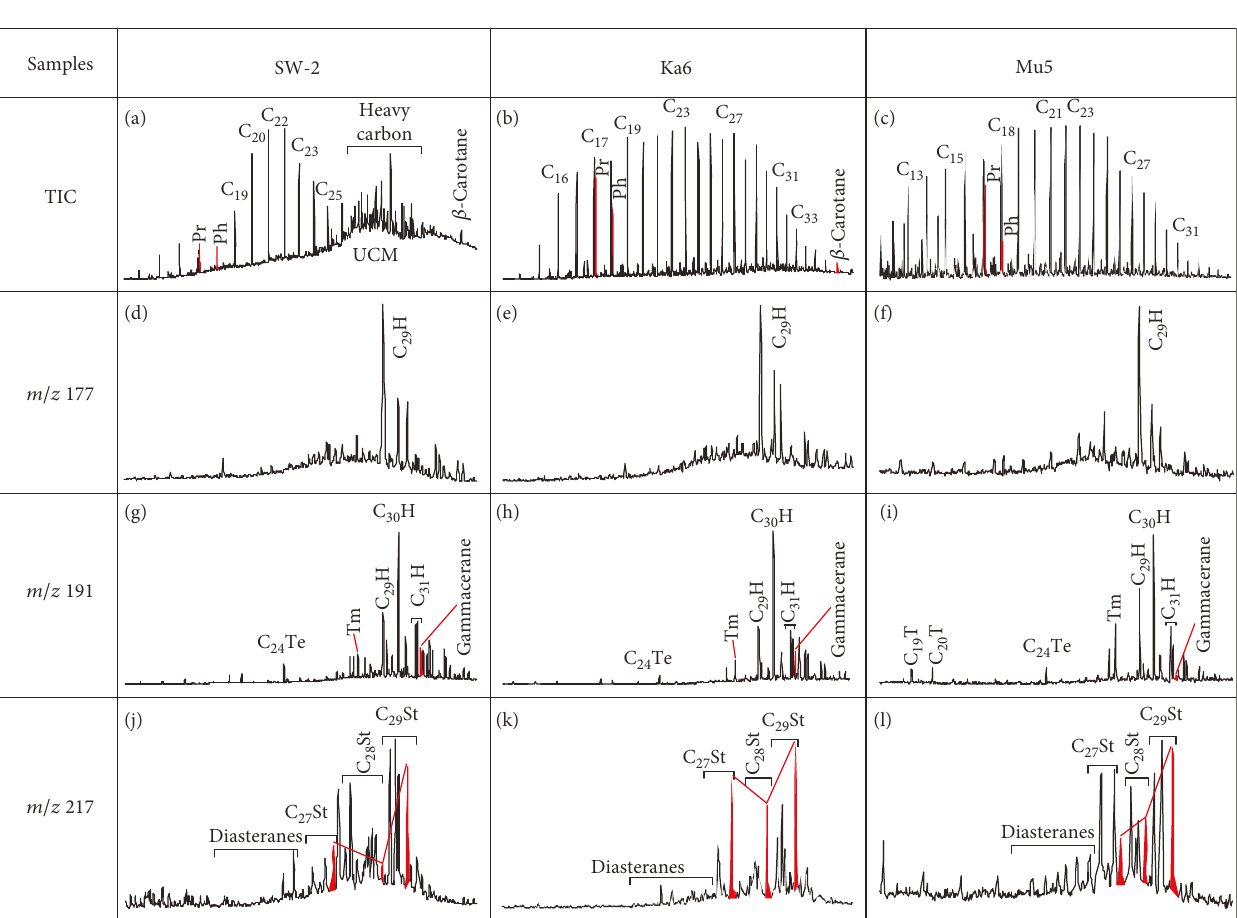
ααα 20R, C /C 27 28 ααα 20S/(20R+20S), and 29